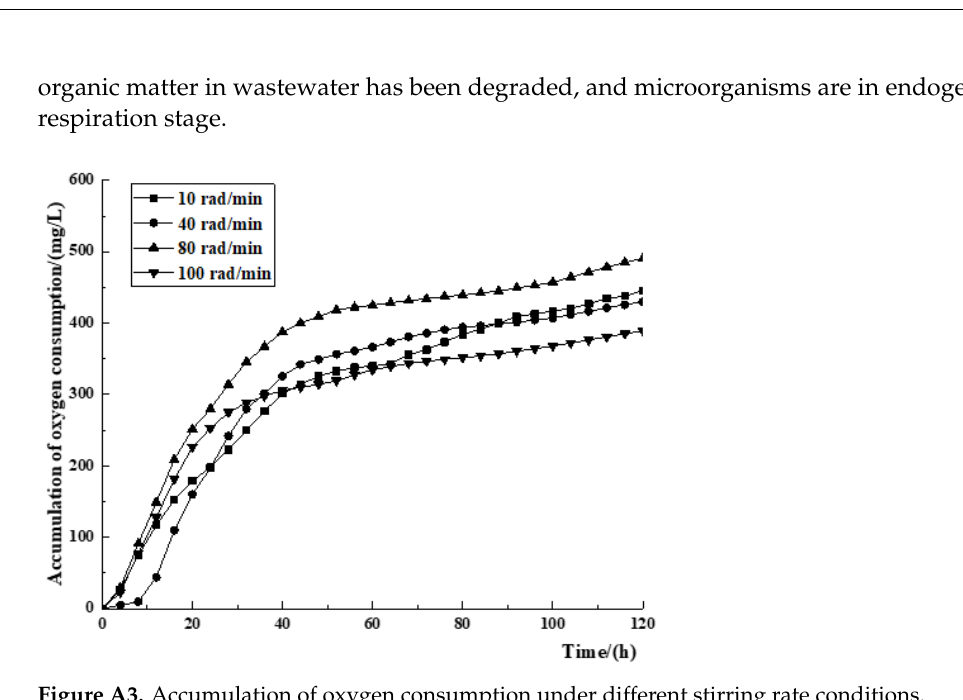
Figure A3. Accumulation of oxygen consumption under different stirring rate conditions. In the stage of organic matter rapid degradation, when the stirring rate increases from 10 rad/min to 80 rad/min, the oxygen consumption increases, and when the stirring rate is higher than 80 rad/min, the oxygen consumption decreases. At the stirring rate of 80 rad/min condition, the cumulative oxygen consumption is the largest (367 mg/L), which was 32.47%, 21.80%, and 23.26% higher than at the 0 rad/min, 40 rad/min, and 100 rad/min, respectively.